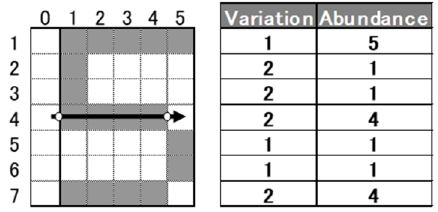
Figure 7. Example of variation and abundance instances of character